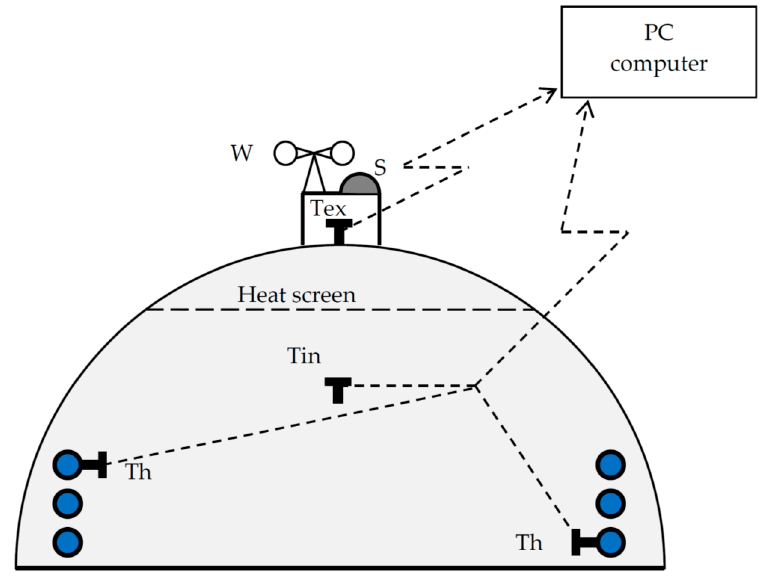
Figure 1. Scheme of the research stand.